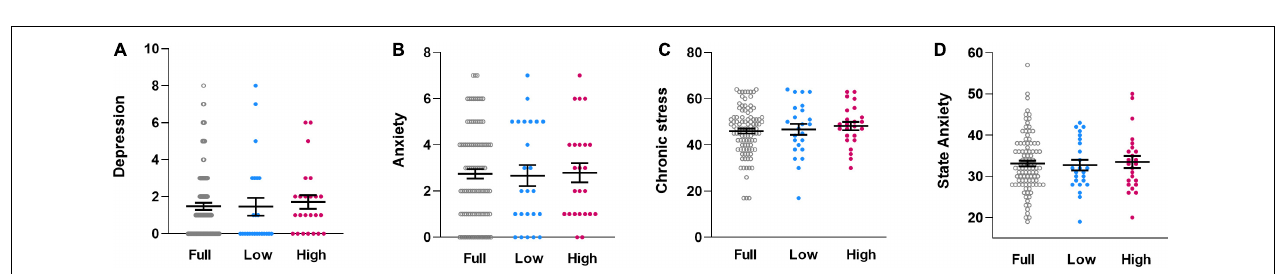
FIGURE 2 | Individual dataplots for visceral pain threshold (A) , visceral sensory threshold (B) and gastrointestinal complaints (C) for the full sample (Full), the lowest quartile subgroup (Low) and the highest quartile subgroup (High) based on cytokine composite score. No significant subgroup differences were found. Lines within plots indicate mean and SEM.